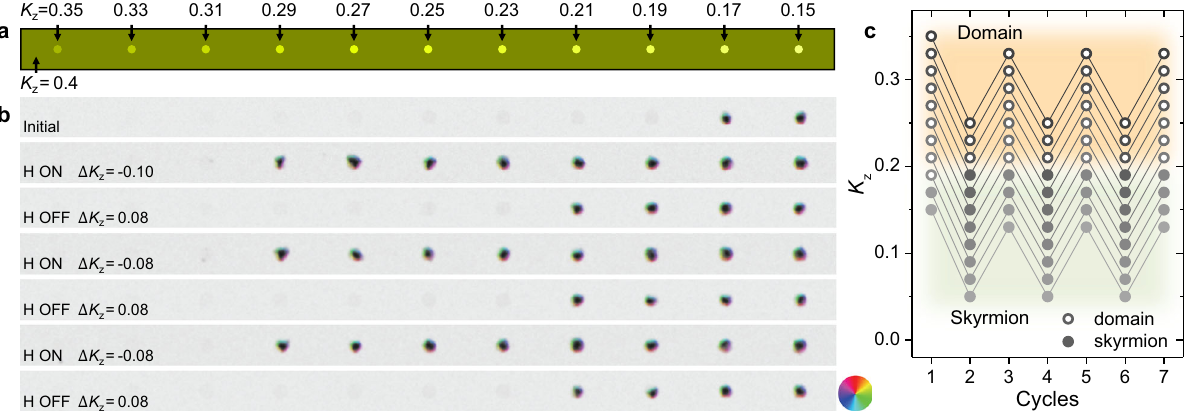
Fig. 4 Monte-Carlo simulation of reversible writing/deleting of skyrmions via anisotropy change near SRT. a Sketch of the anisotropy landscape, highlighting pinning sites with various magnetic anisotropy (labeled on top). b Simulated domains over three anisotropy change cycles, showing reversible writing/deleting of skyrmions on the sites with K z = 0.29, 0.27, 0.25 and 0.23. The amount of anisotropy change is indicated as 4 K z . Exchange and DMI constants remain the same, where J ¼ 1, β ¼ 0 : 3 (see methods). Color wheel indicates the in-plane magnetization direction. c Anisotropy dependent single-domain (open circles) and skyrmion (gray circles) evolution, summarizing panel b